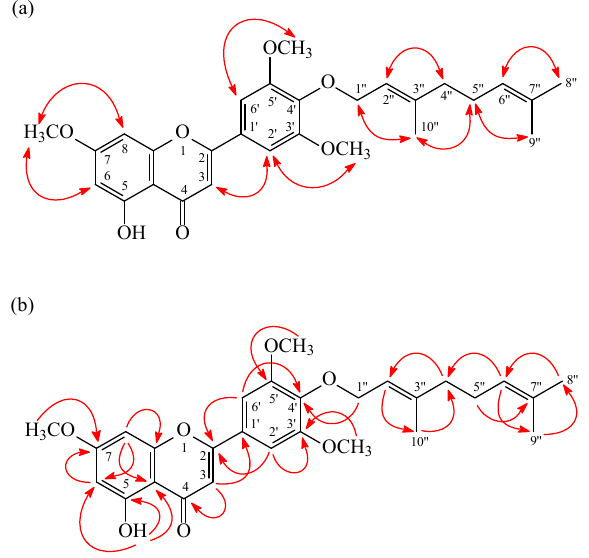
Figure 2. NOESY ( a ) and HMBC ( b ) correlations of 1 .